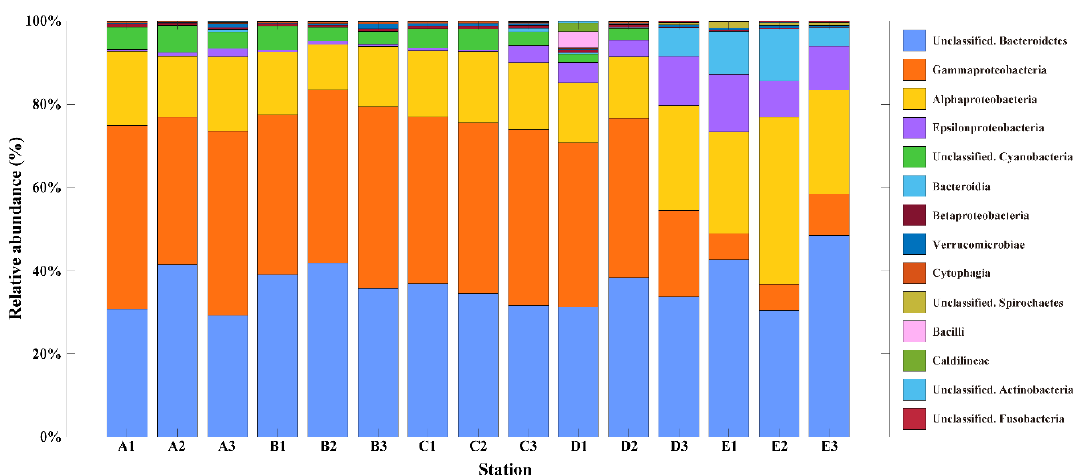
Figure 3. The relative abundance (%) of the surface Marian Cove bacterial communities at the class level during the summer of 2018. Note that taxa occurred at > 1 % in a total sum of relative abundance of all stations were represented.